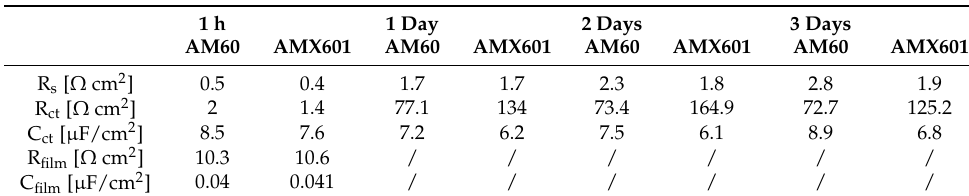
Table 4. The fitting parameters of EIS for AM60 and AMX601 alloys, immersed in NaOH solution (pH ≈ 10.5).